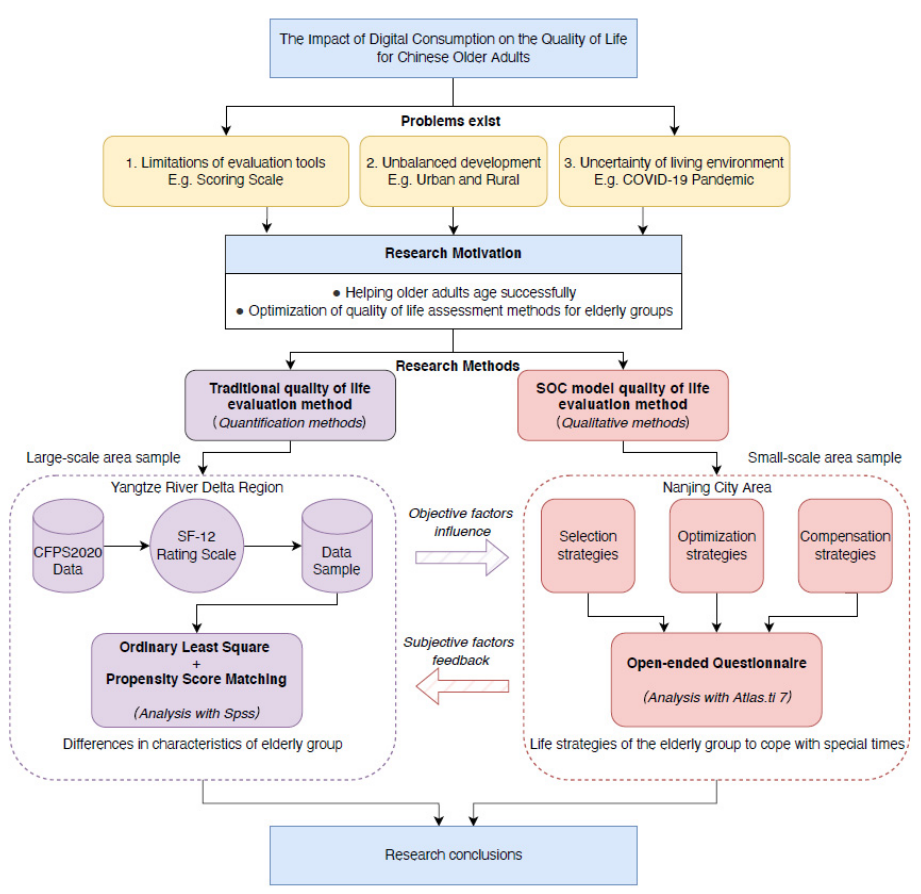
Figure 1. The study flow diagram. Note: SOC—selective optimization with compensation.